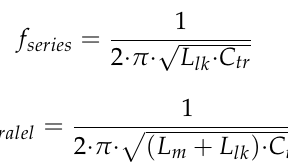
Figure 8. Simplified high-frequency transformer model, referred to primary side. Two resonance frequencies, f series and f paralel , are defined as series and parallel reso- nance frequencies of the transformer, respectively. f series is determined by L lk and C tr and f paralel are determined by ( L m + L lk ) and C tr